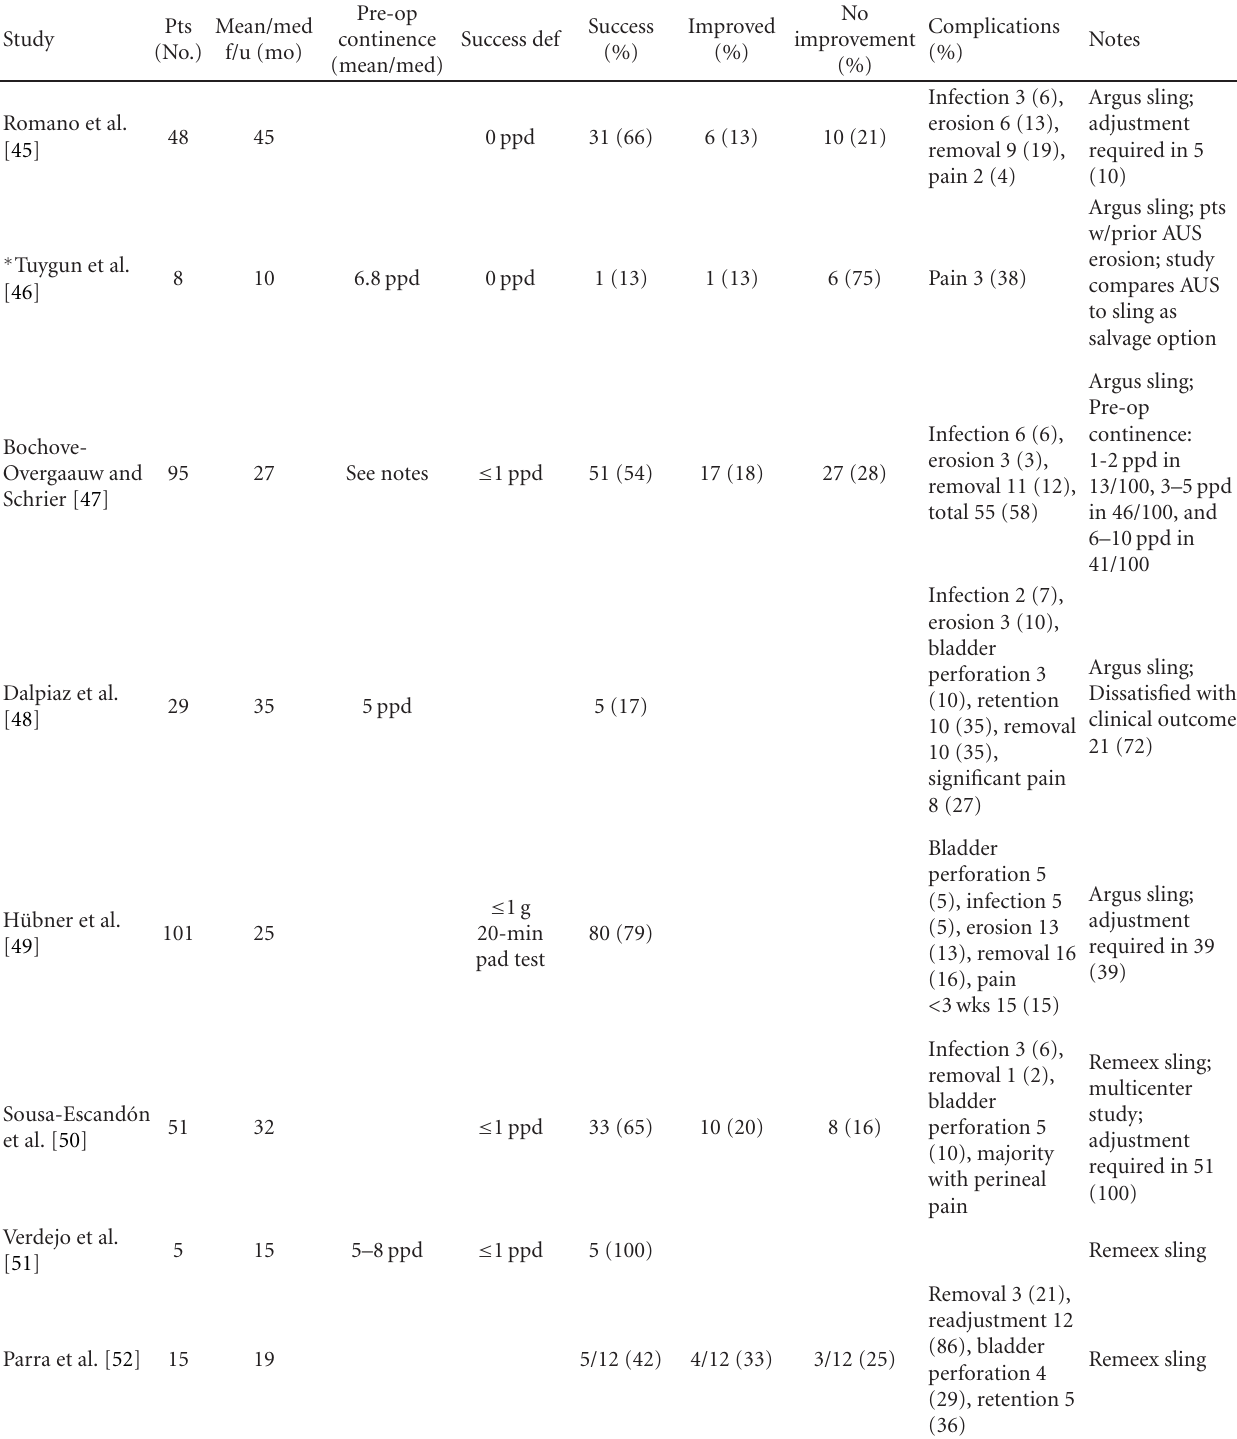
Table 3: Comparison of results of adjustable retropubic sling placement in adult males with